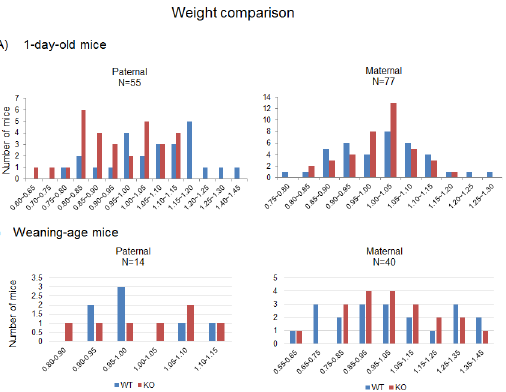
Fig 4. Mutational effects on the body weight of the mouse. Male and female heterozygotes were individually bred with their wild-type littermates for the paternal and maternal transmission of the knockin allele. The body weight of each pup was first divided by the average weight of a given litter, providing a percentile score for each pup. The values on the X axis indicate these percentile values, while the values on the Y axis indicate the number of mice. ( A ) The one-day-old pups inheriting the knockin allele paternally showed much smaller body weights than their littermates. ( B ) The weight profiles of the pups at the weaning age did not show any major changes between the heterozygotes and wild-type littermates in both paternal and maternal transmission of the knockin allele.